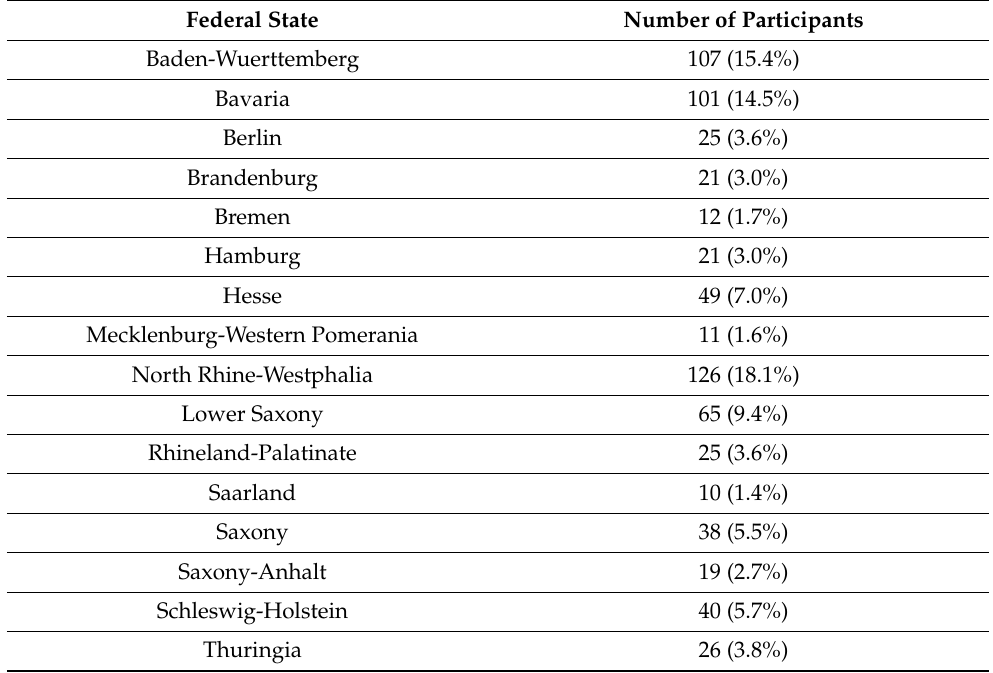
Table 3. Number of participants by federal state (in alphabetical order) in absolute values and in percent (%).